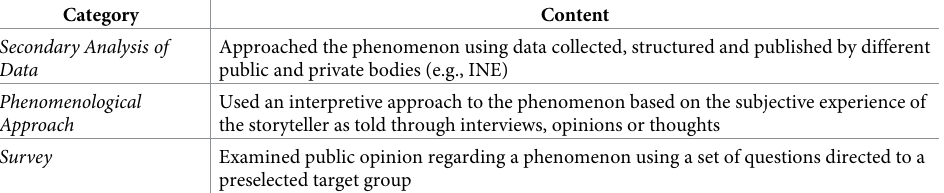
Table 9. Method categorical variables